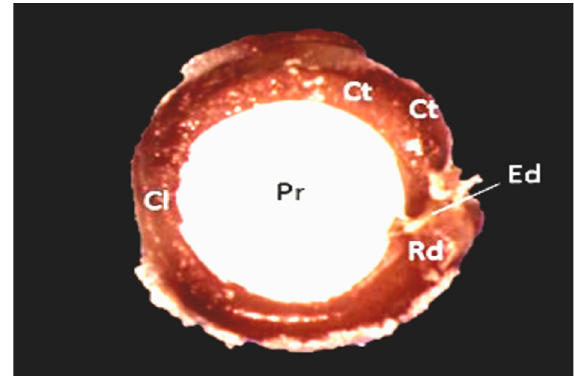
Figure 2. Characterization of tissues of quinoa seeds subjected to the tetrazolium salt. Ct: cotyledon; Ed: endosperm; Pr: perisperm; Rd: